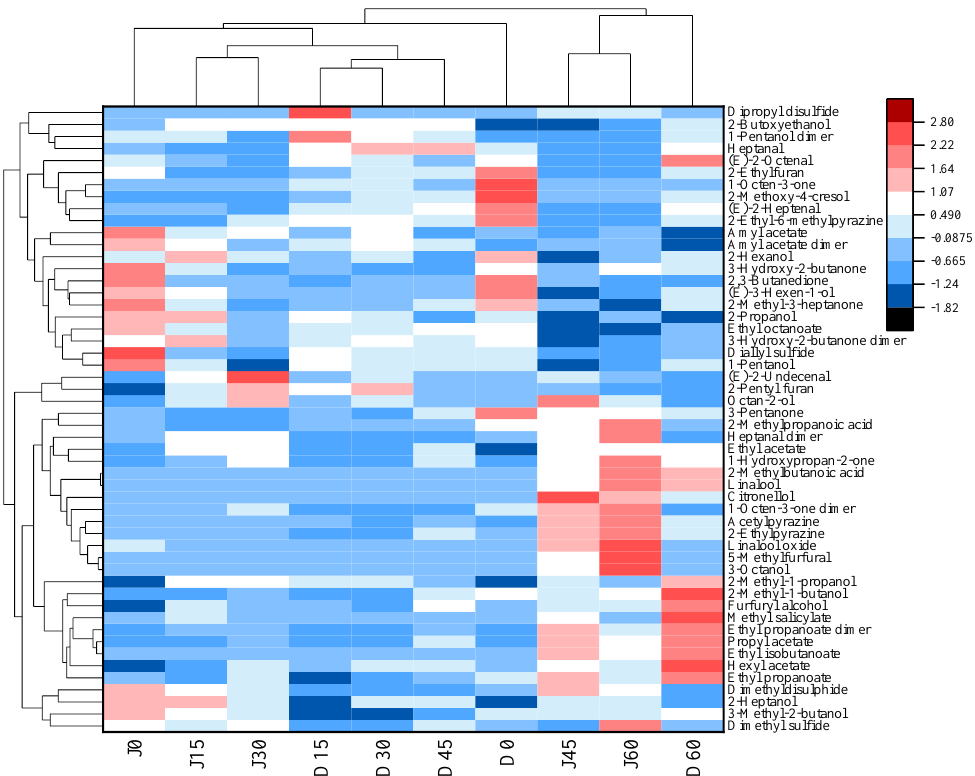
Figure 8. Heat map and cluster analysis of jujube fruits at different periods. D0, D15, D30, D45, and D60 represent DZ refrigerated for 0, 15, 30, 45, and 60 days, respectively; J0, J15, J30, J45, and J60 represent JS refrigerated for 0, 15, 30, 45, and 60 days, respectively.